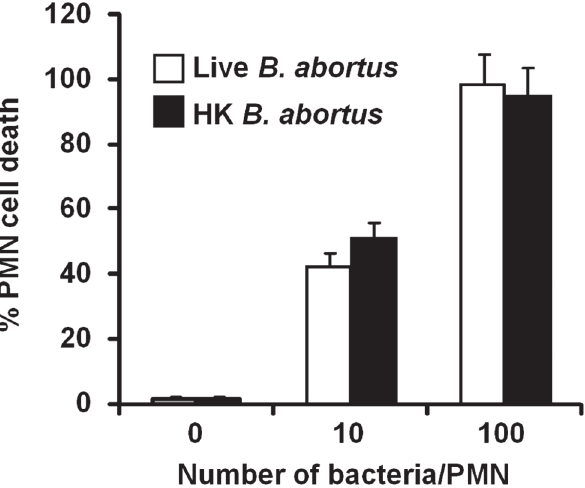
Fig 3. Live and heat-killed B . abortus induce PMN cell death. Heparinized blood was incubated with live or heat-killed (HK) B . abortus for two hours (10 and 100 bacteria/PMN). PMN population was analyzed by flow cytometry for cell death using AquaDead and Annexin V markers, as described in Fig 2. Percentages of PMNs positive for any marker were determined. Experiments were repeated at least three times. No significant differences were detected between live and HK B . abortus .